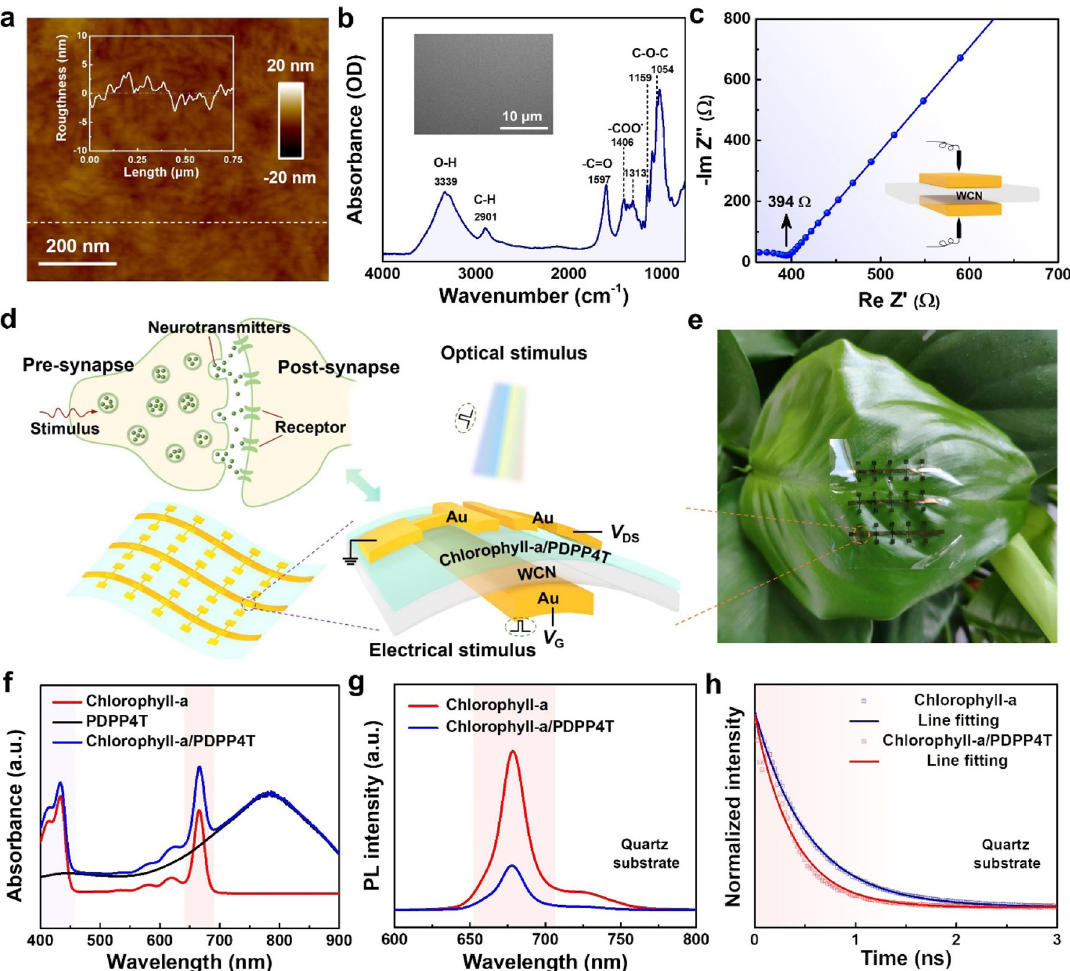
Fig. 1 Overview of bioinspired organic optoelectronic synaptic transistors. a AFM image of the WCN. The inset is the roughness curve of the WCN surface obtained from the line scan. Scale bar, 200 nm. b FTIR spectrum of the WCN. The inset is the top-view SEM image of the WCN. Scale bar, 10 μ m. c Cole − Cole plot of the WCN. The inset shows the schematic diagram of device testing. d Schematic illustration of a biological synapse and an optoelectronic synaptic transistor. e A photograph of an optoelectronic synaptic transistor array. f UV – vis absorption spectra of the chlorophyll-a fi lm, PDPP4T fi lm, and PDPP4T/chlorophyll-a hybrid fi lm, respectively. g Steady-state PL spectra of the chlorophyll-a fi lm and PDPP4T/chlorophyll-a hybrid fi lm on quartz ( λ ex = 430 nm). h Transient PL spectra of the chlorophyll-a fi lm and PDPP4T/ chlorophyll-a hybrid fi lm on quartz ( λ ex = 405